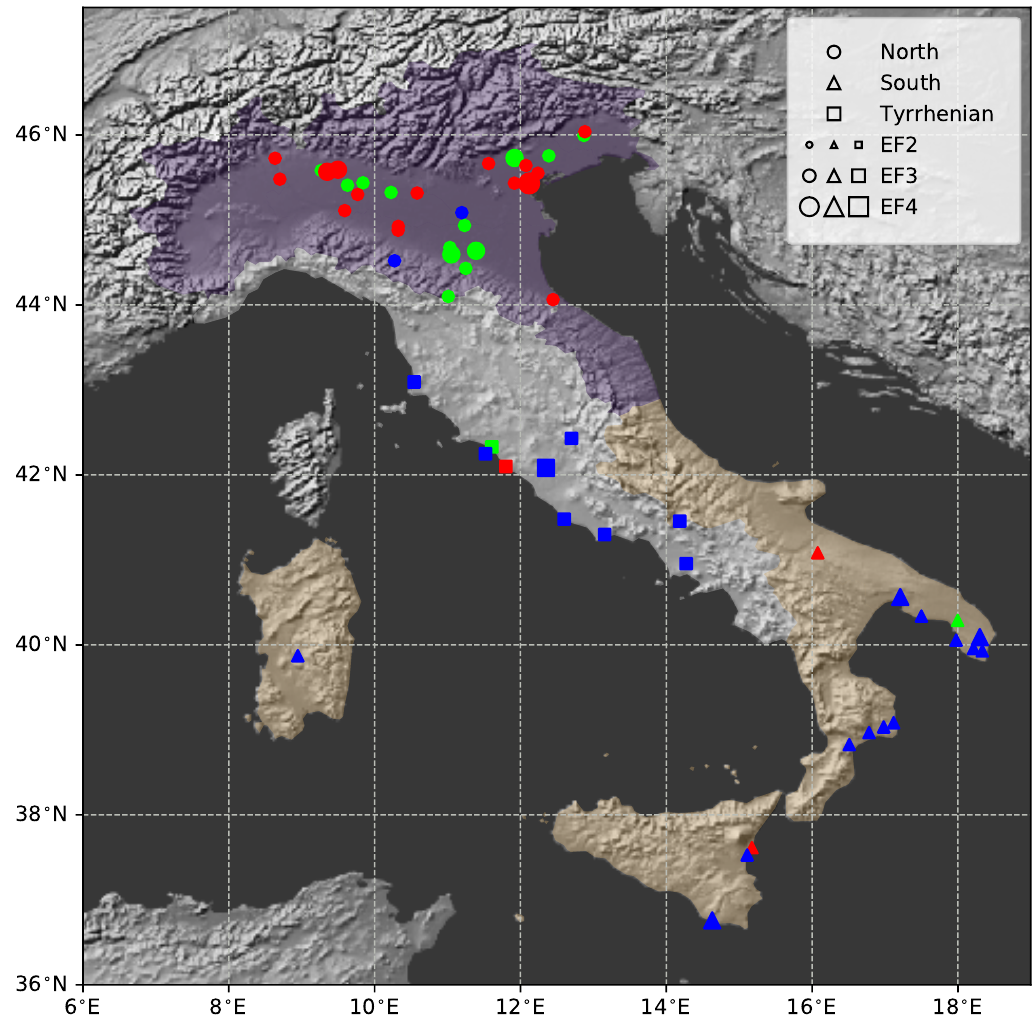
Figure 1. Locations of EF2+ tornadoes occurred in Italy during the period 2000–2018. The colors indicate the seasons: spring (green), summer (red), and autumn (blue). Different markers represent three different regions: northern Italy (circles), the Tyrrhenian coast (squares), southern Italy (triangles). The increasing size of the markers denote stronger intensity of tornadoes (from EF2 to EF4)—see the corresponding